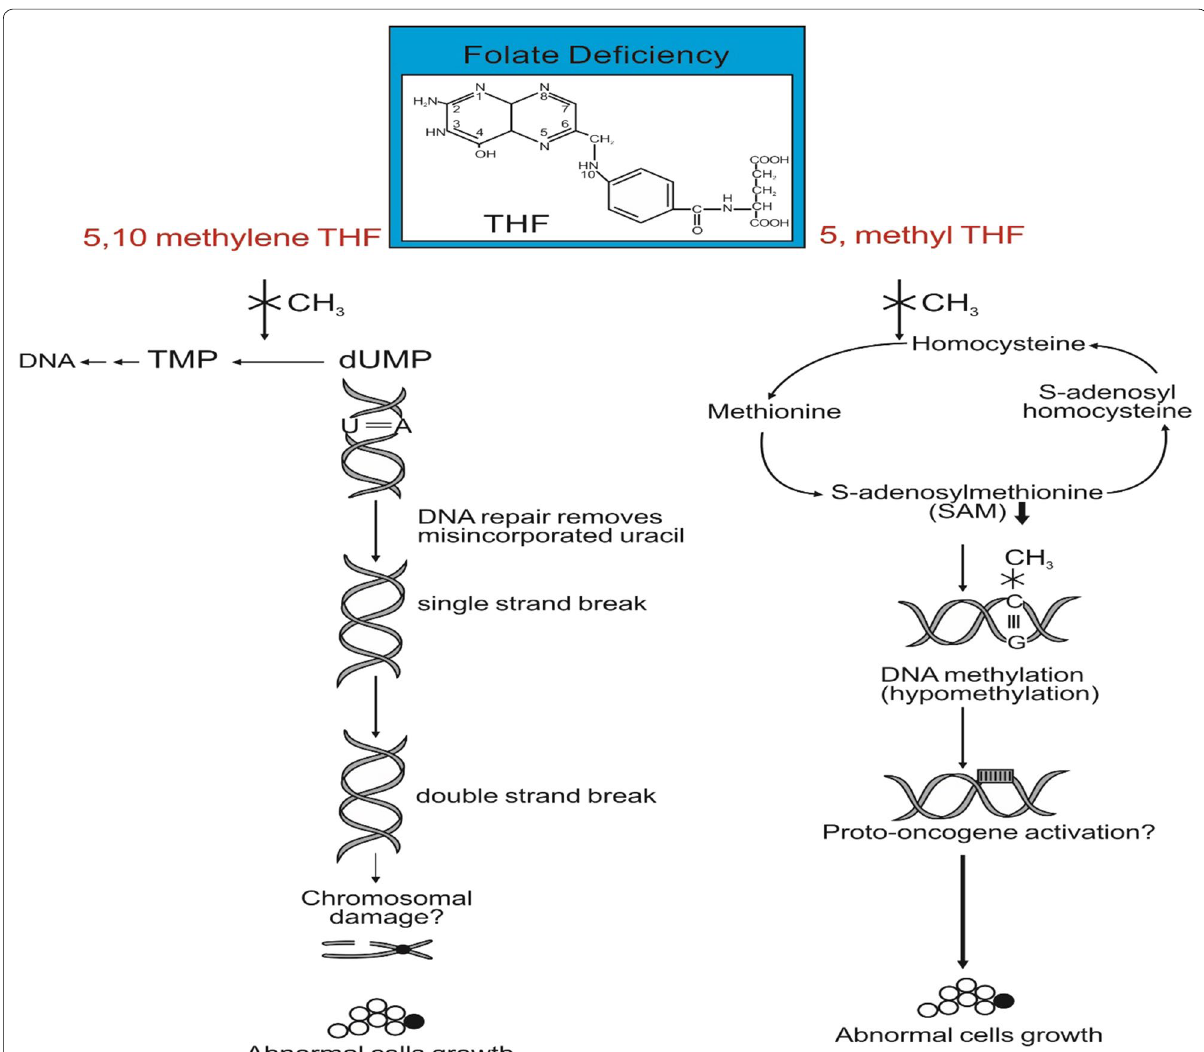
Fig. 1 How folate deficiency leads to genomic instability? Two way: 5,10-methylene-THF, 5,10-methylenetetrahydrofolate; 5, methyl THF, 5-meth- ylenetetrahydrofolate; THF, tetrahydrofolate; C, cytosine; G, guanine; X denotes no capability to donate a methyl group (CH 3 ); TMP, thymidylate monophosphate; desoxyuridylate monophosphate, dUMP (adopted from Duthie